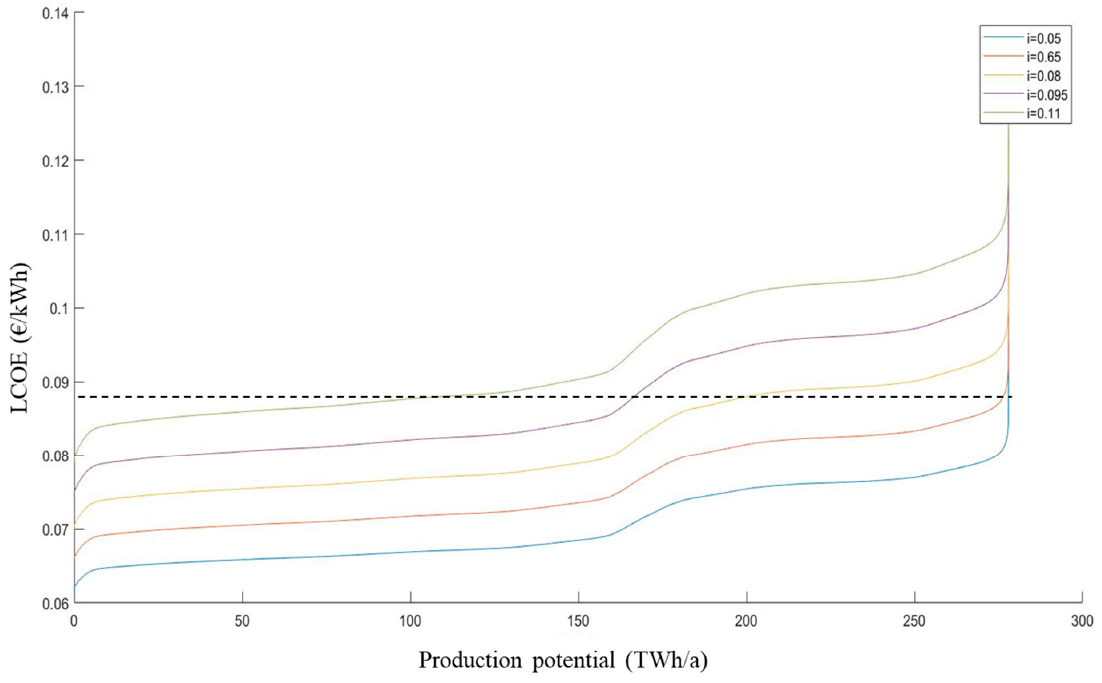
Figure 7. The cost–potential curves for electricity generation from monocrystalline solar cells at different discount rates and the average FIT 2.0 of 0.088 Euro/kWh as a dashed line.